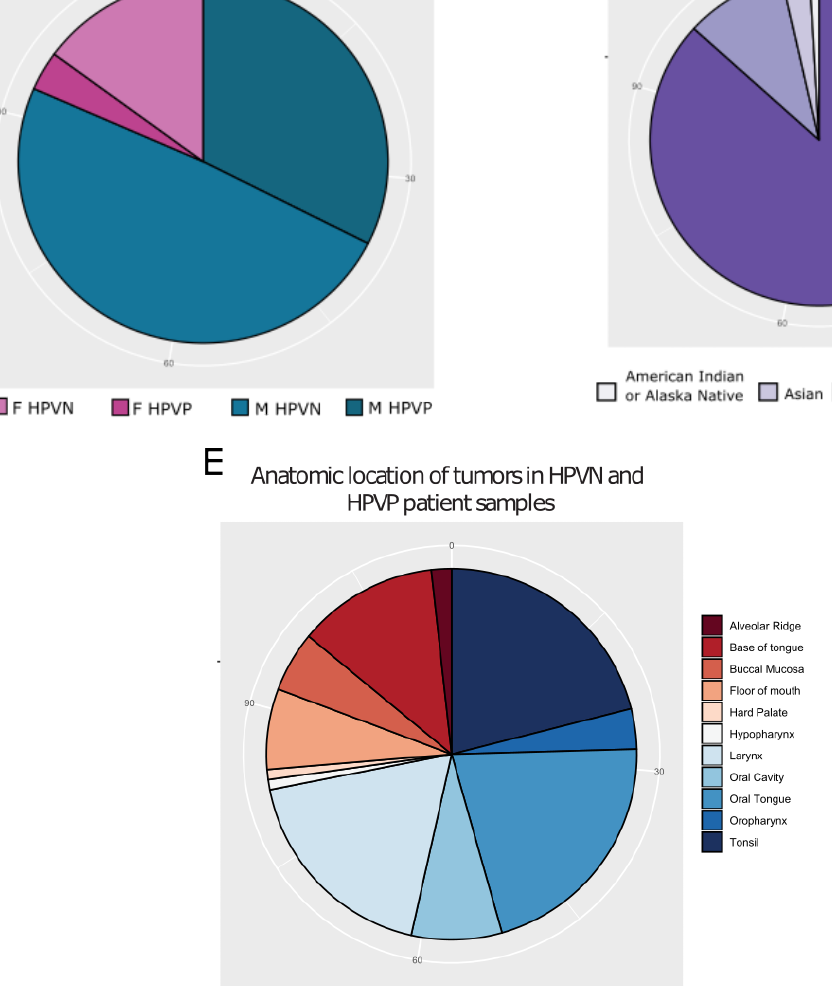
Figure 1 . Clinical data of the TCGA HNSCC HPV- positive and negative patients. Patients were filtered according to the HPV status using the information regarding p16 expression and in situ hybridization information (only patients with information present were included in the study; n = 114, HPVP = 41, HPVN = 73). ( A ) Distribution of age at cancer diagnosis between two groups of patients, HPVP and HPVP; ( B ) distribution of patients in different age groups, and sidewise comparison of age groups and HPV status; ( C ) representation of male and female patients, HPVP and HPVN; ( D ) representation of different races, independent of sex or HPV status; ( E ) distribution of different anatomical sites where cancer originated; ( F , G ) a closer look at the specific location of HPVN patients ( F ) and HPVP ( G ). 2.2. Clustering of Samples Confirms That HPVN and HPVP Are Two Separate Comparable Groups To explore clustering and similarity of samples, we analyzed the two experimental groups, HPVN and HPVP, by PCA and clustering on heatmap. PCA revealed that the two groups (detailed explanation in Material and Methods) clustered mostly as two separate